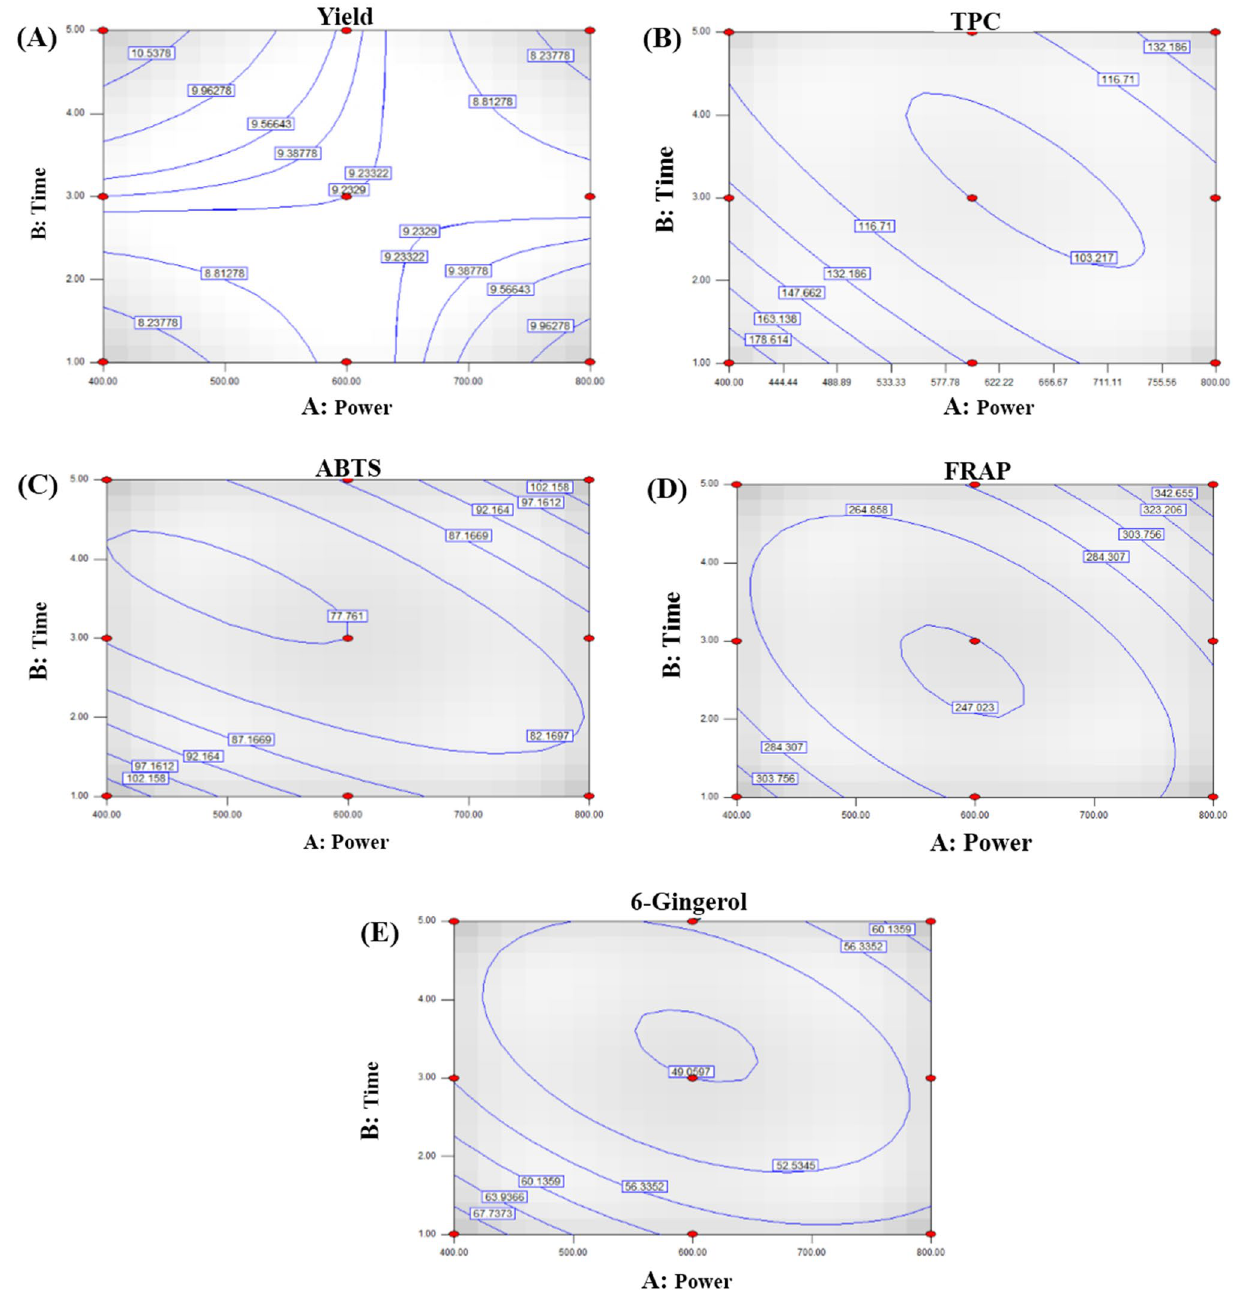
Figure 1. Contour plots of the effect of the interaction between power and time on ( A ) yield, ( B ) TPC, ( C ) ABTS, ( D ) FRAP, and ( E )